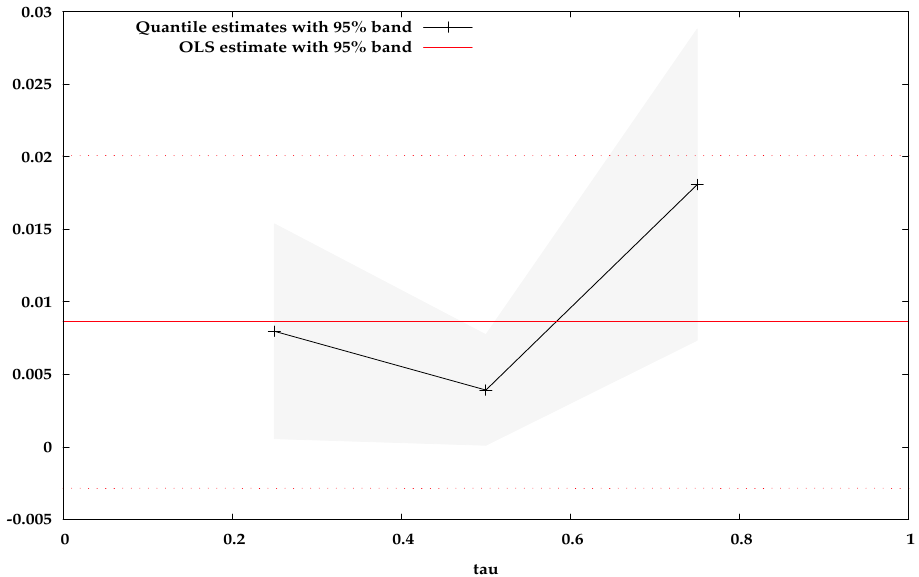
Figure 4. Coefficients across the quantiles with the bootstrapped confidence intervals for regression of semi-deviation of returns vs. semi-deviation for ROA ( τ = 0.25;0.5;0.75, the OLS confidence interval is from − 0.0028 to 0.0201).